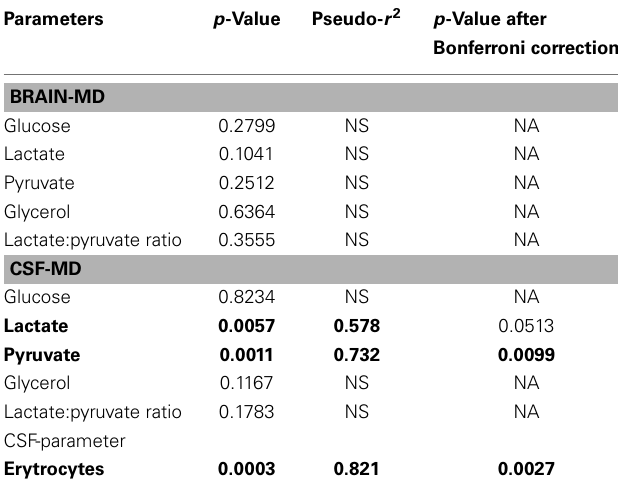
Table 5 | Parameters and univariate correlation to patient outcome